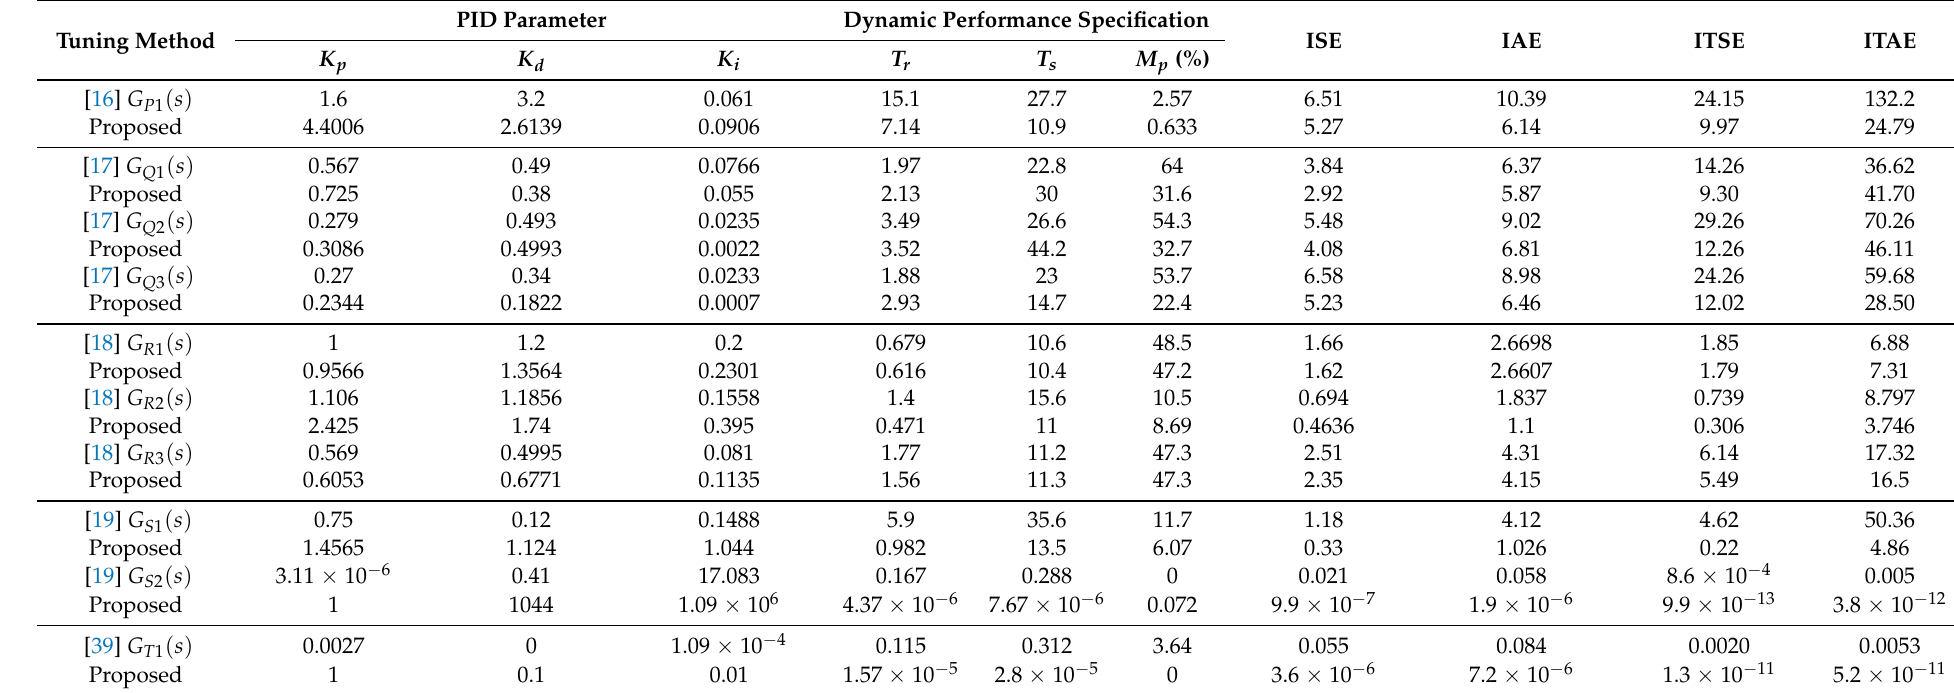
Table 3. Performance of the PID controller tuning